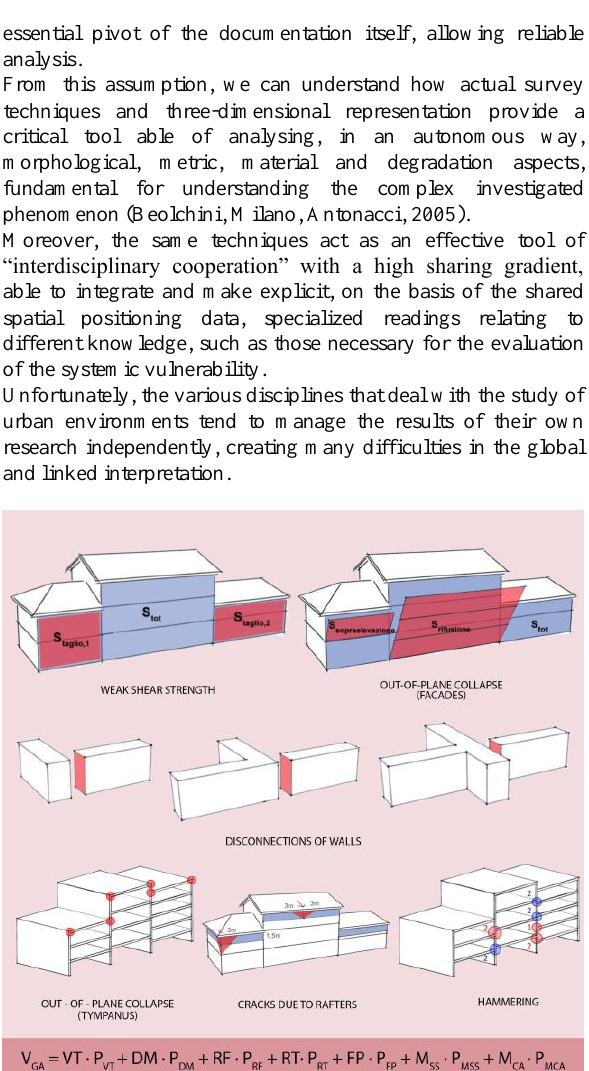
Figure 1. Indicators used for the seismic